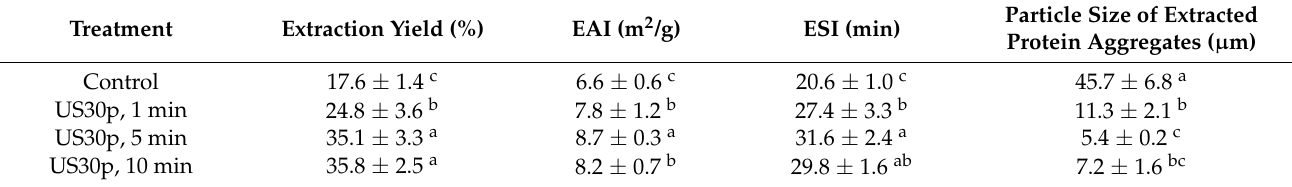
Table 2. The impact of ultrasonic time (at fixed US power density = 26.8 W/cm 2 ) on the protein extraction yield, particle size, and selected functionality (emulsifying properties) of HPI.